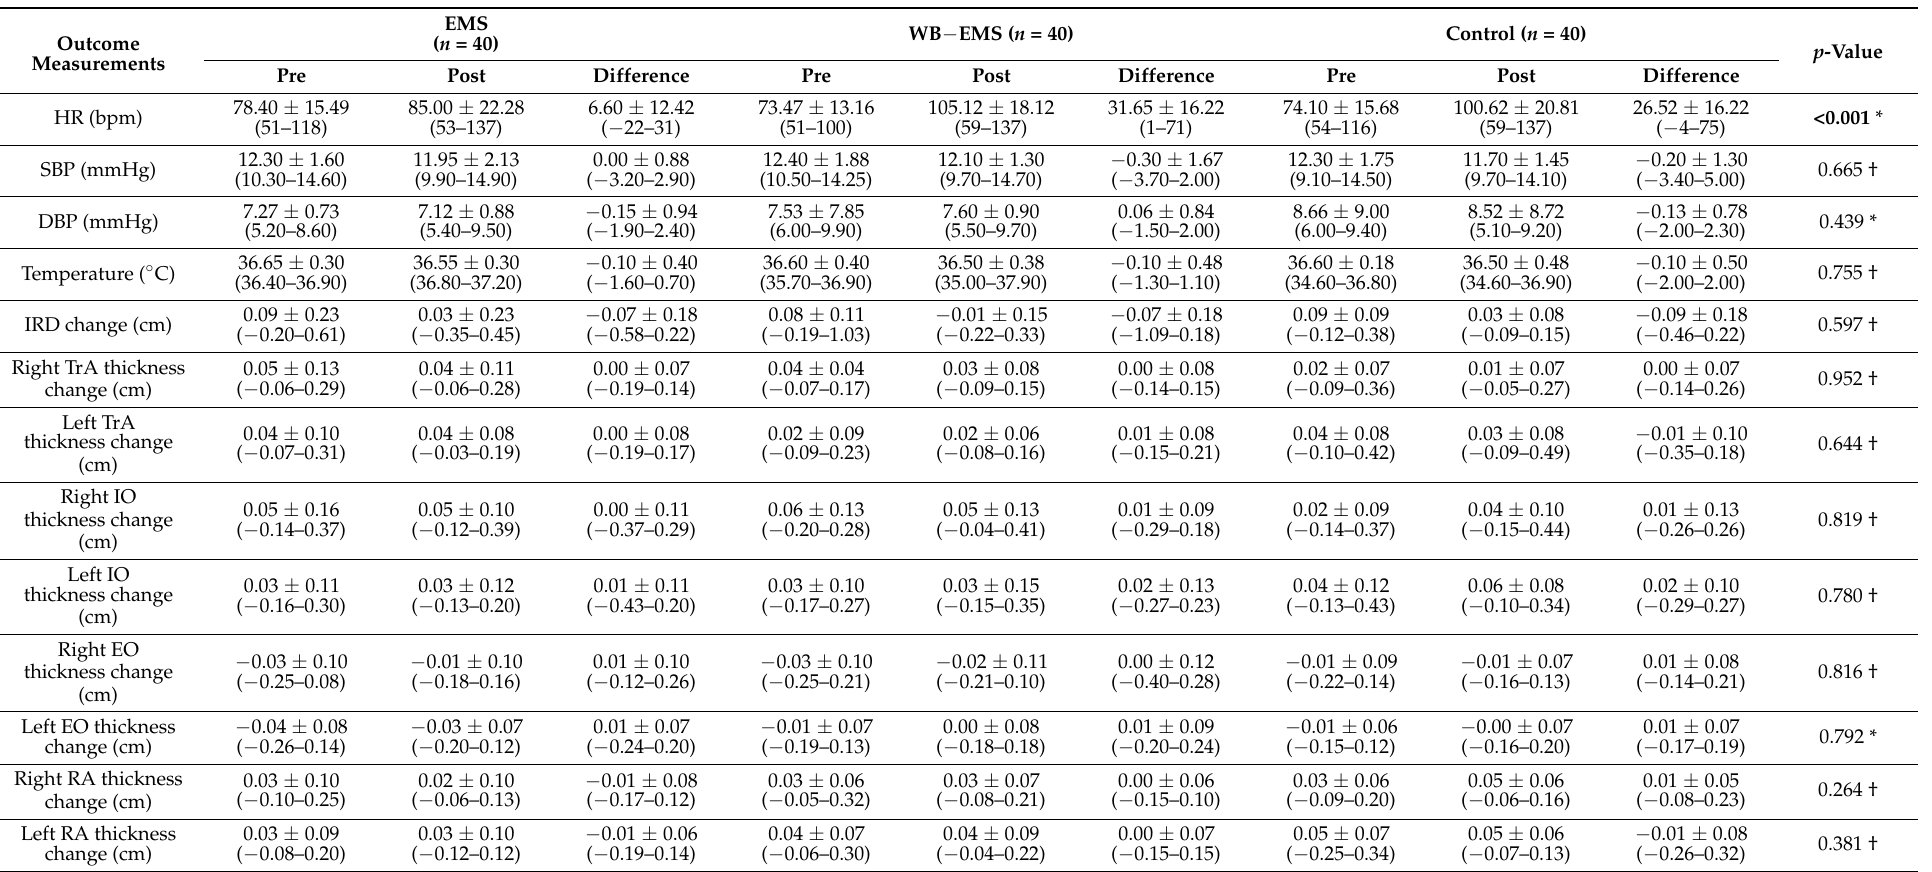
Table 4. Comparisons of the outcome measurement differences among the EMS, WB-EMS, and control groups after interventions. Outcome